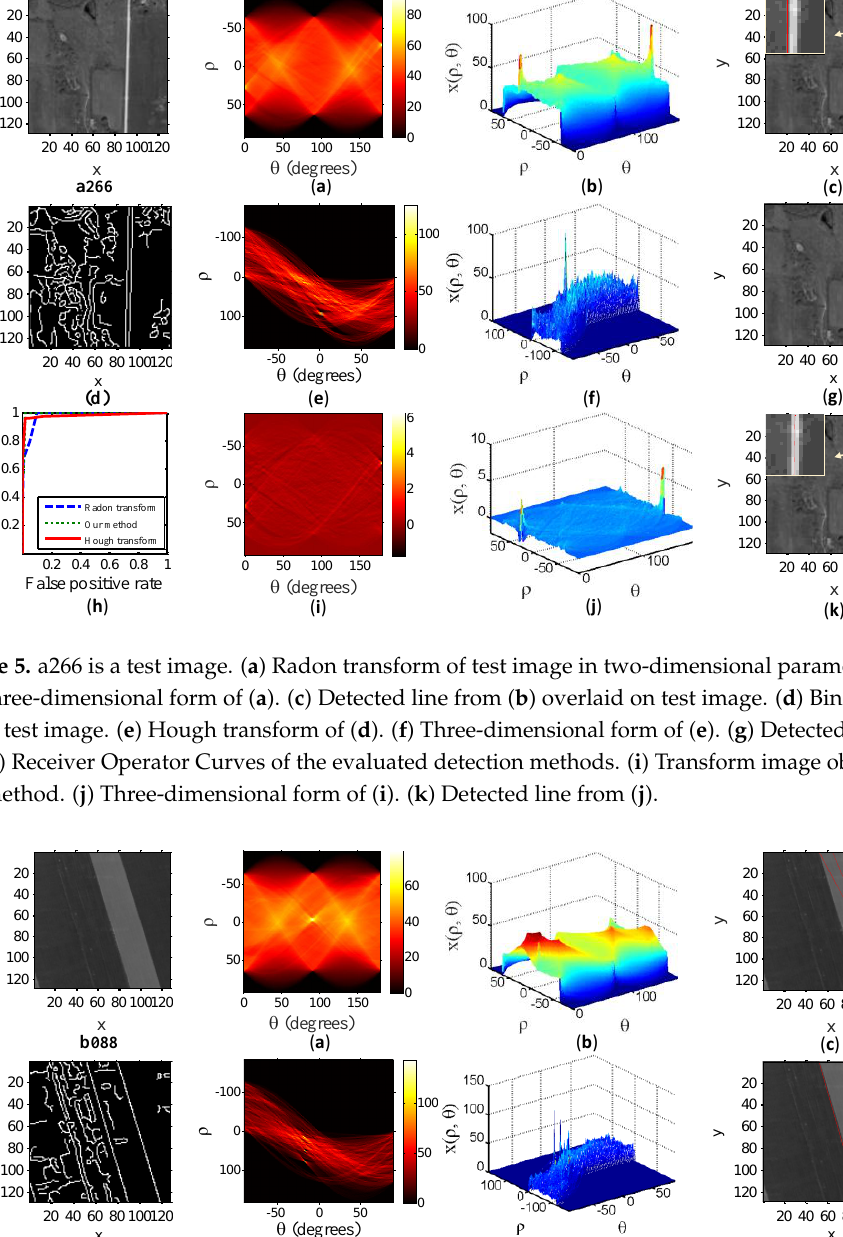
( f ). ( h ) Receiver Operator Curves of the evaluated detection methods. ( i ) Transform image obtained by our method. ( j ) Three-dimensional form of ( i ). ( k ) Detected line from ( j ).